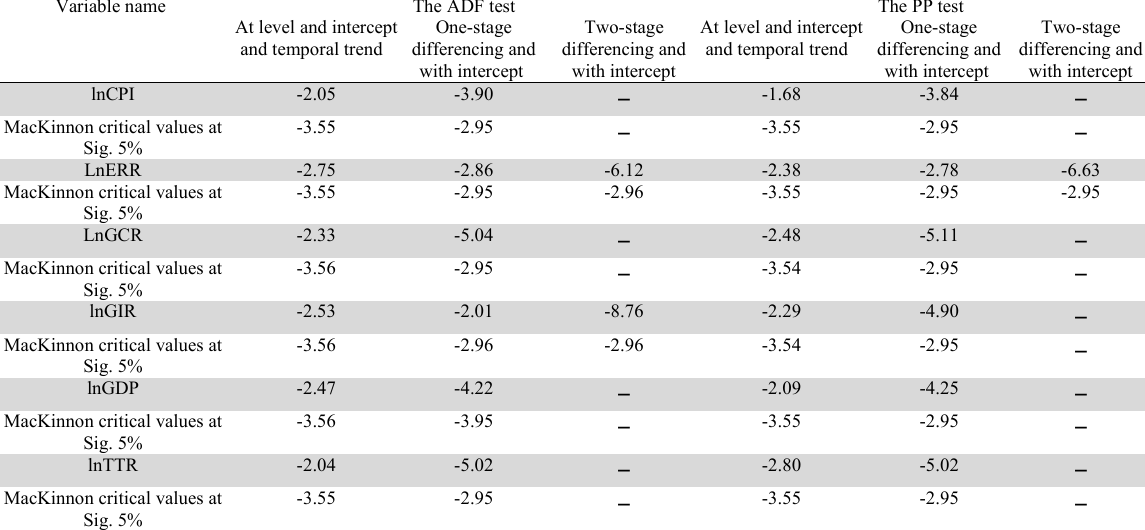
The results of the Augmented Dickey-Fuller test and Phillips–Perron test